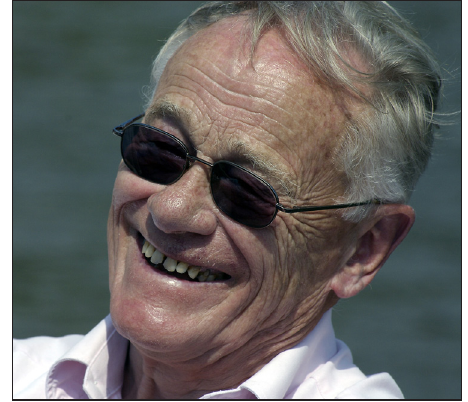
Figure 3: Henry Cleere (Photo: Interna- tional Council on Monuments and Sites